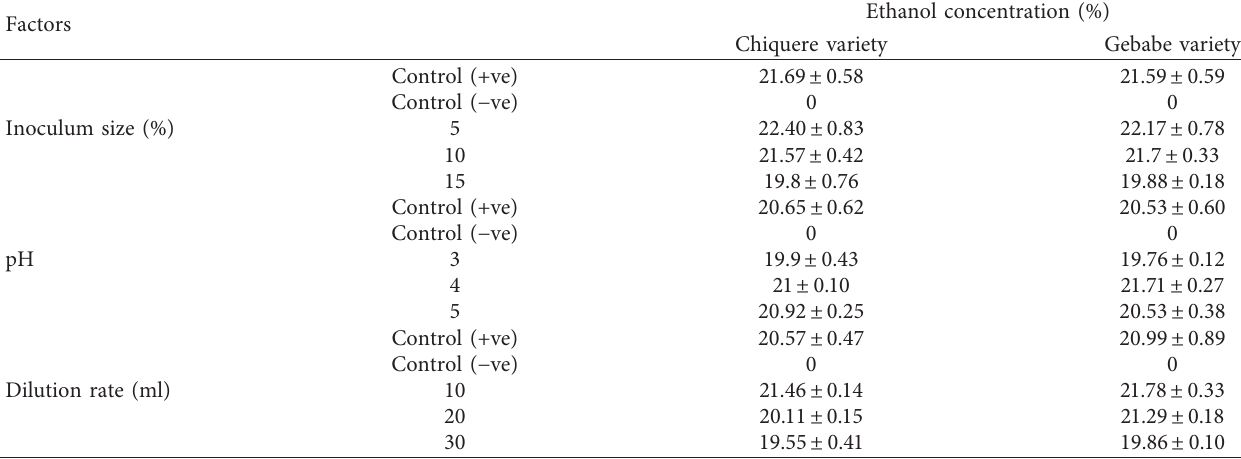
Table 7: Effect of various factors on ethanol production from Chiquere and Gebabe varieties of sweet sorghum.